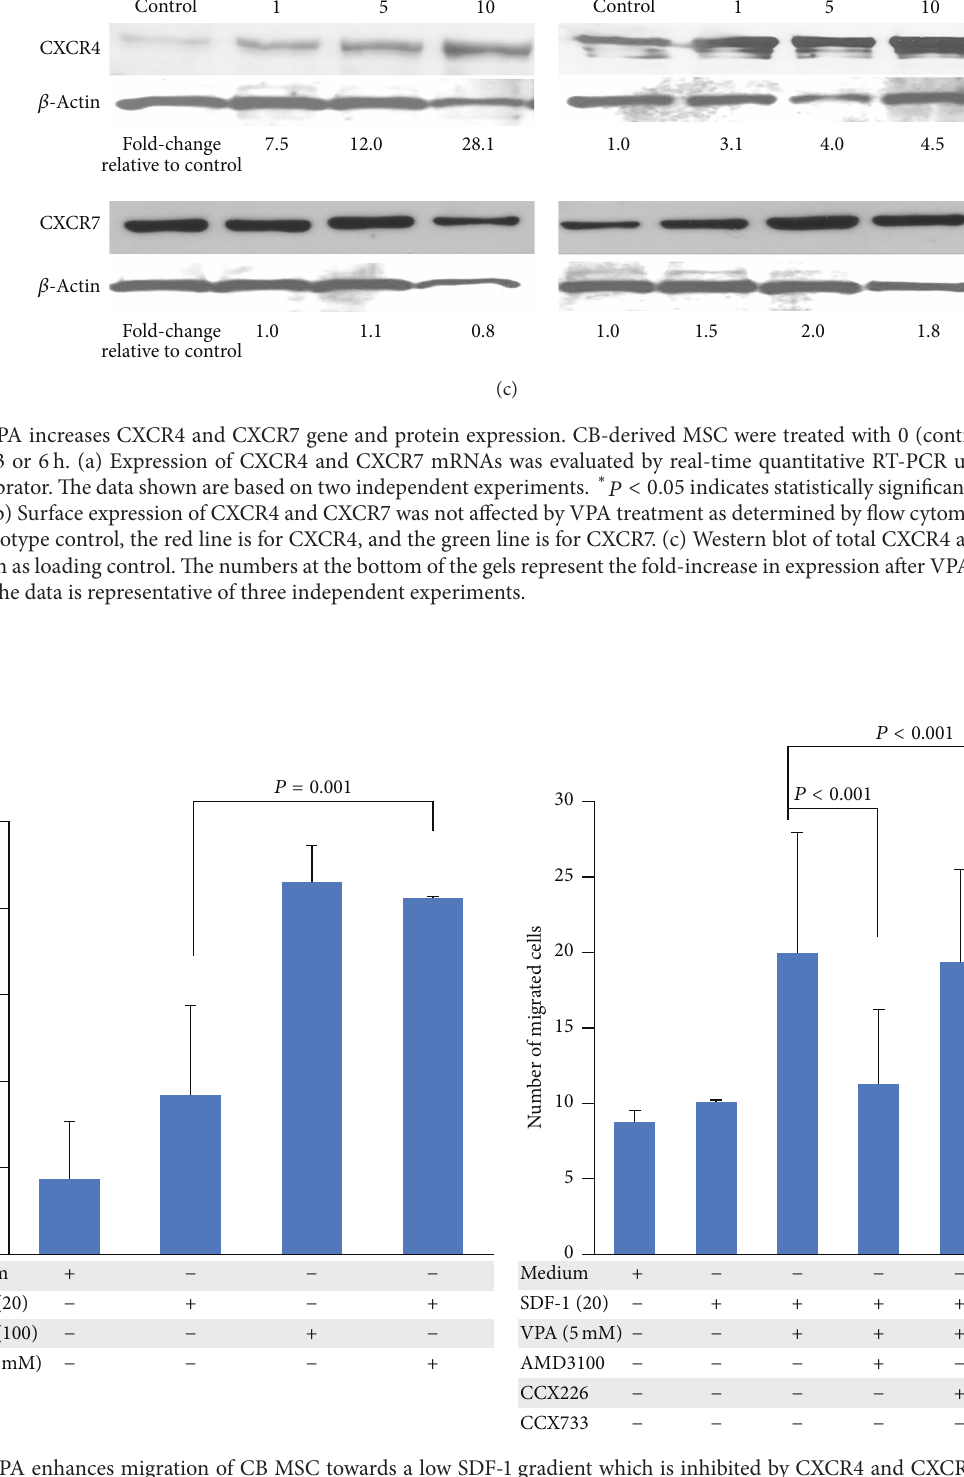
Figure 2: VPA enhances migration of CB MSC towards a low SDF-1 gradient which is inhibited by CXCR4 and CXCR7 antagonists. CB- derived MSC were preincubated with or without 5mM VPA for 3 h and allowed to migrate across Matrigel towards a low (20ng/mL) or high (100ng/mL) SDF-1 gradient. Cells were also incubated with CXCR4 antagonist AMD3100, CXCR7 antagonist CCX733, or the inactive CXCR7 antagonist CCX226. The data are based on two independent experiments; 𝑃 ≤ 0.001 indicates statistically significant